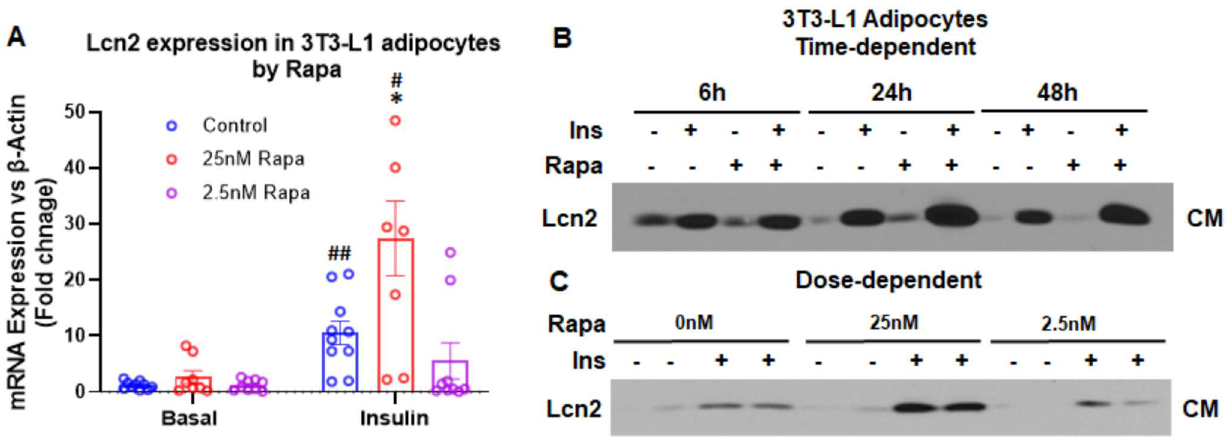
Figure 3. Lcn2 expression and secretion by rapamycin in 3T3-L1 adipocytes. ( A ) Dose-dependent mRNA expression of Lcn2. ( B ) Time- and dose-dependent secretion of Lcn2 protein by rapamycin. Results are presented as mean ± SEM ( n = 6 for A). * p < 0.05 versus controls. # p < 0.05, ## p < 0.01 versus corresponding basal group.